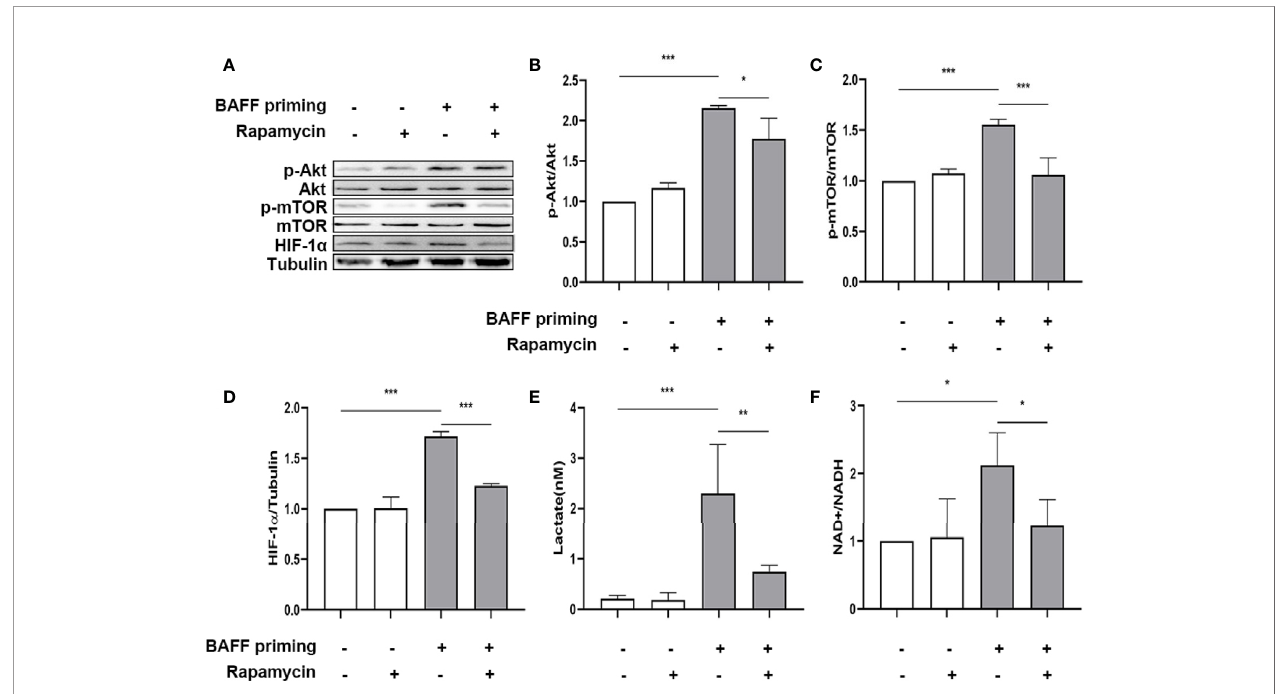
FIGURE 9 | Rapamycin suppressed HIF-1 a and metabolic reprogramming in primary microglial cells induced by BAFF priming. Primary microglia were pretreated with 100 nM rapamycin for 1 h, then treated with BAFF (10 ng/ml) or vehicle for 24 h, and rested for 5 days. (A) Whole-cell extracts were collected on day 6 and levels of Akt, p-Akt, mTOR, p-mTOR, and HIF-1 a were detected by Western blot. Densitometric quanti fi cation of p-Akt/Akt (B) , p- mTOR/mTOR (C) , and HIF-1 a /tubulin (D) in (A) . (E) The production of lactate in the supernatants was measured on day 6; (F) The ratio of NAD+/NADH in the whole-cell lysates was measured on day 6. Data are mean ± SEM (n = 9); Kruskal-Wallis test with Turkey post hoc test; *p < 0.05, **p < 0.01, and ***p <